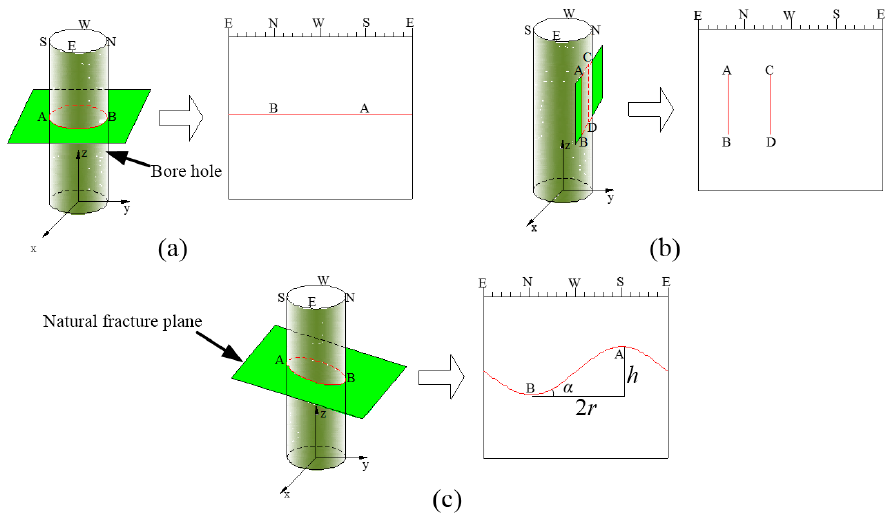
Figure 10. The intersection of the drill hole and the structure surface: ( a ) vertical intersection; ( b ) parallel intersection and ( c ) inclined intersection.